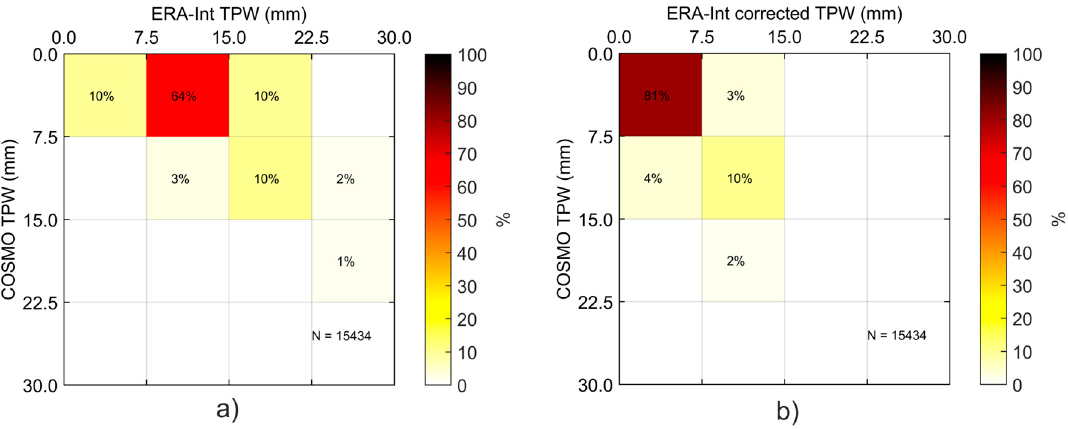
Figure 6. Contingency tables of the COSMO and ERA-Int TPW (in mm) for the April to September period (only cases with height differences between models greater than 1000 m are used) ( a ) uncorrected ERA-Int; ( b ) ERA-Int with exponential correction.